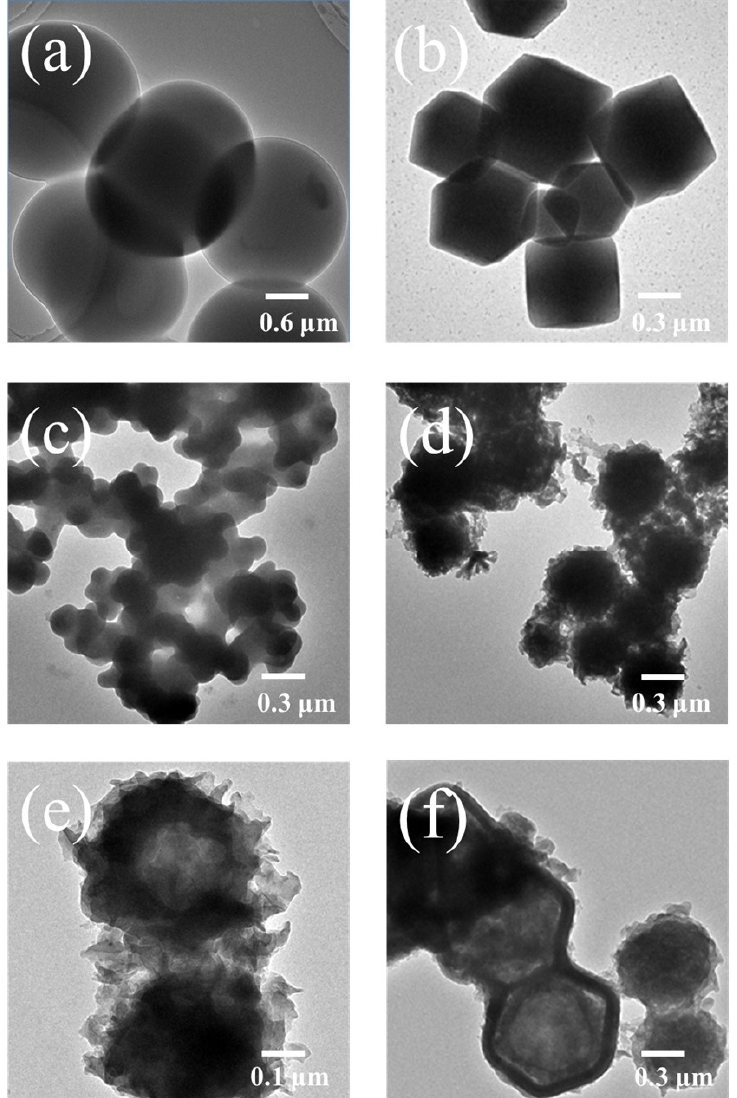
Figure 3. TEM images of the ( a ) carbon-hydrolysate, ( b ) Co-MOF (ZIF-67), ( c ) C1-ZIF-67 and ( d ) ( e , f )